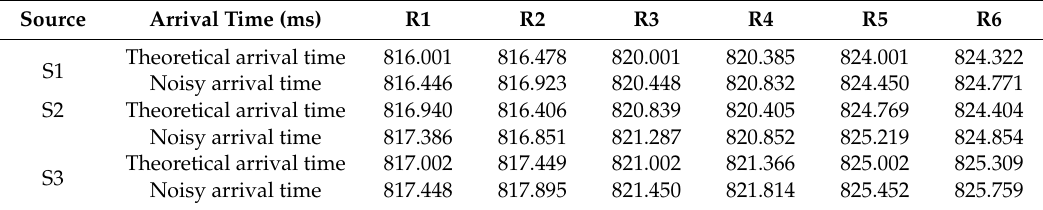
Figure 4. Schematic diagram of the calculation of the theoretical path: ( a ) the tunnel model, and ( b ) expanded side view of the tunnel model. Table 2. Theoretical arrival time and noisy arrival time of each